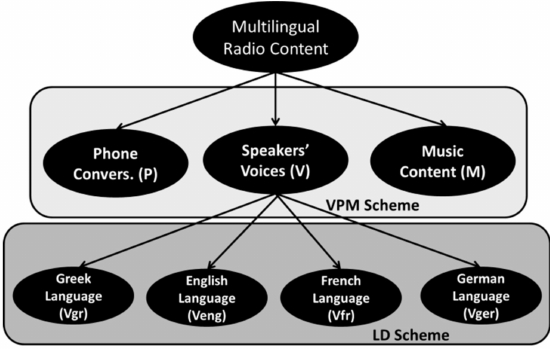
Figure 2. Hierarchical Classification